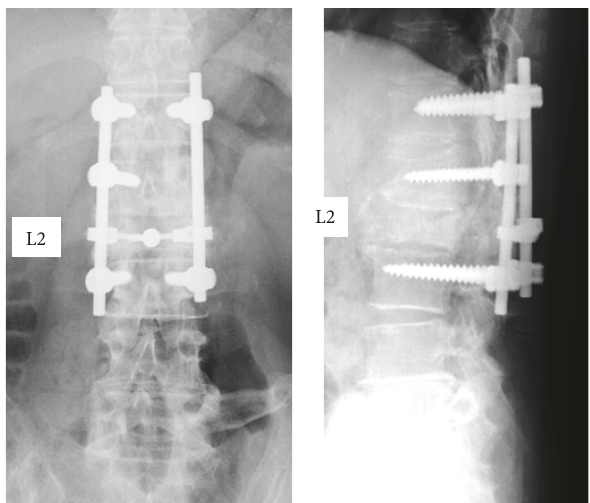
Figure 1: X-ray image of the spine at the first visit. Deformation of L2 vertebral body after posterior fixation surgery.